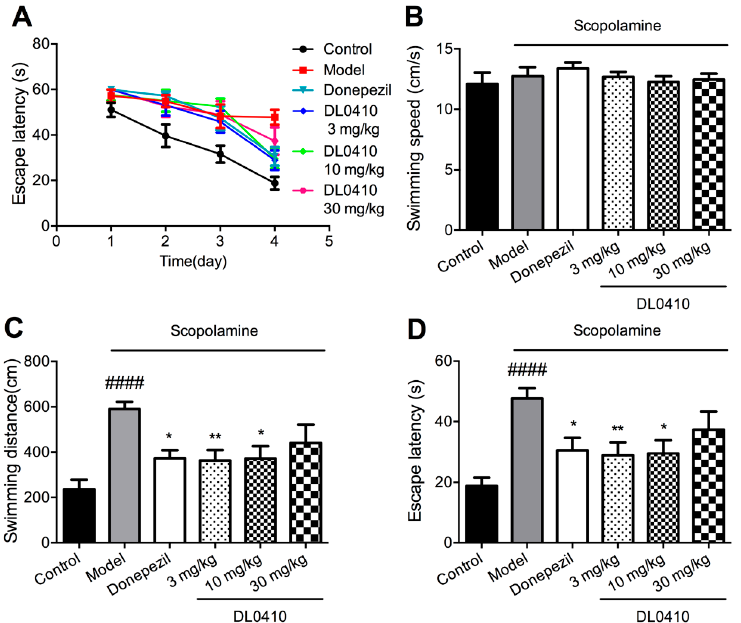
Figure 3. The improvement of DL0410 on the impaired spatial memory induced by scopolamine in the navigation trial of the Morris water maze. Data were expressed as mean ± SEM ( n = 12). ( A ) The mean escape latency in the navigation trials; ( B ) The mean swimming speed of mice on the fourth day; ( C ) The swimming distance of mice to find the hidden platform on the fourth day; ( D ) The escape latency of mice to find the hidden platform on the fourth day. #### p < 0.0001 vs. the control group; * p < 0.05 and ** p < 0.01 vs. the model group.